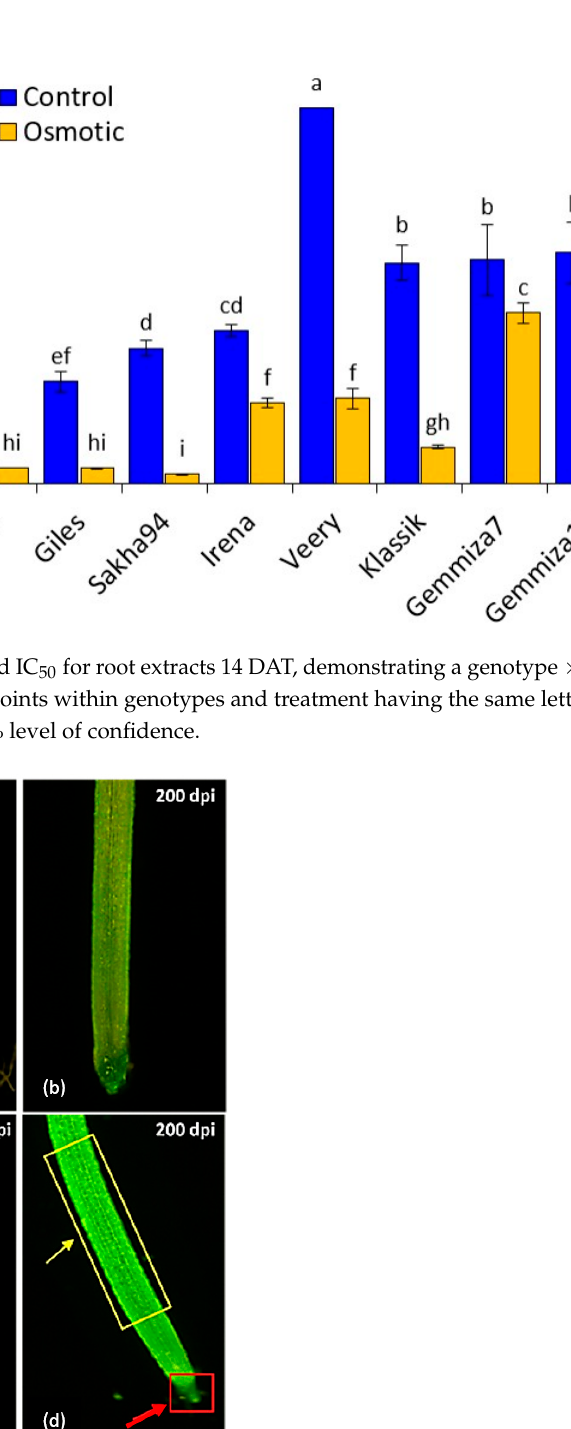
Figure 4. ROS generation in eight bread wheat seedling roots at 14 DAT. ( a ) Control for adapted genotypes; ( b ) control for non-adapted genotypes; ( c ) osmotic treatment for adapted genotypes; ( d ) osmotic treatment for non-adapted genotypes. In sensitive genotypes’ root tip, the areas of elongation and differentiation exhibiting ROS localization are marked with red- and yellow-colored quadrangles,